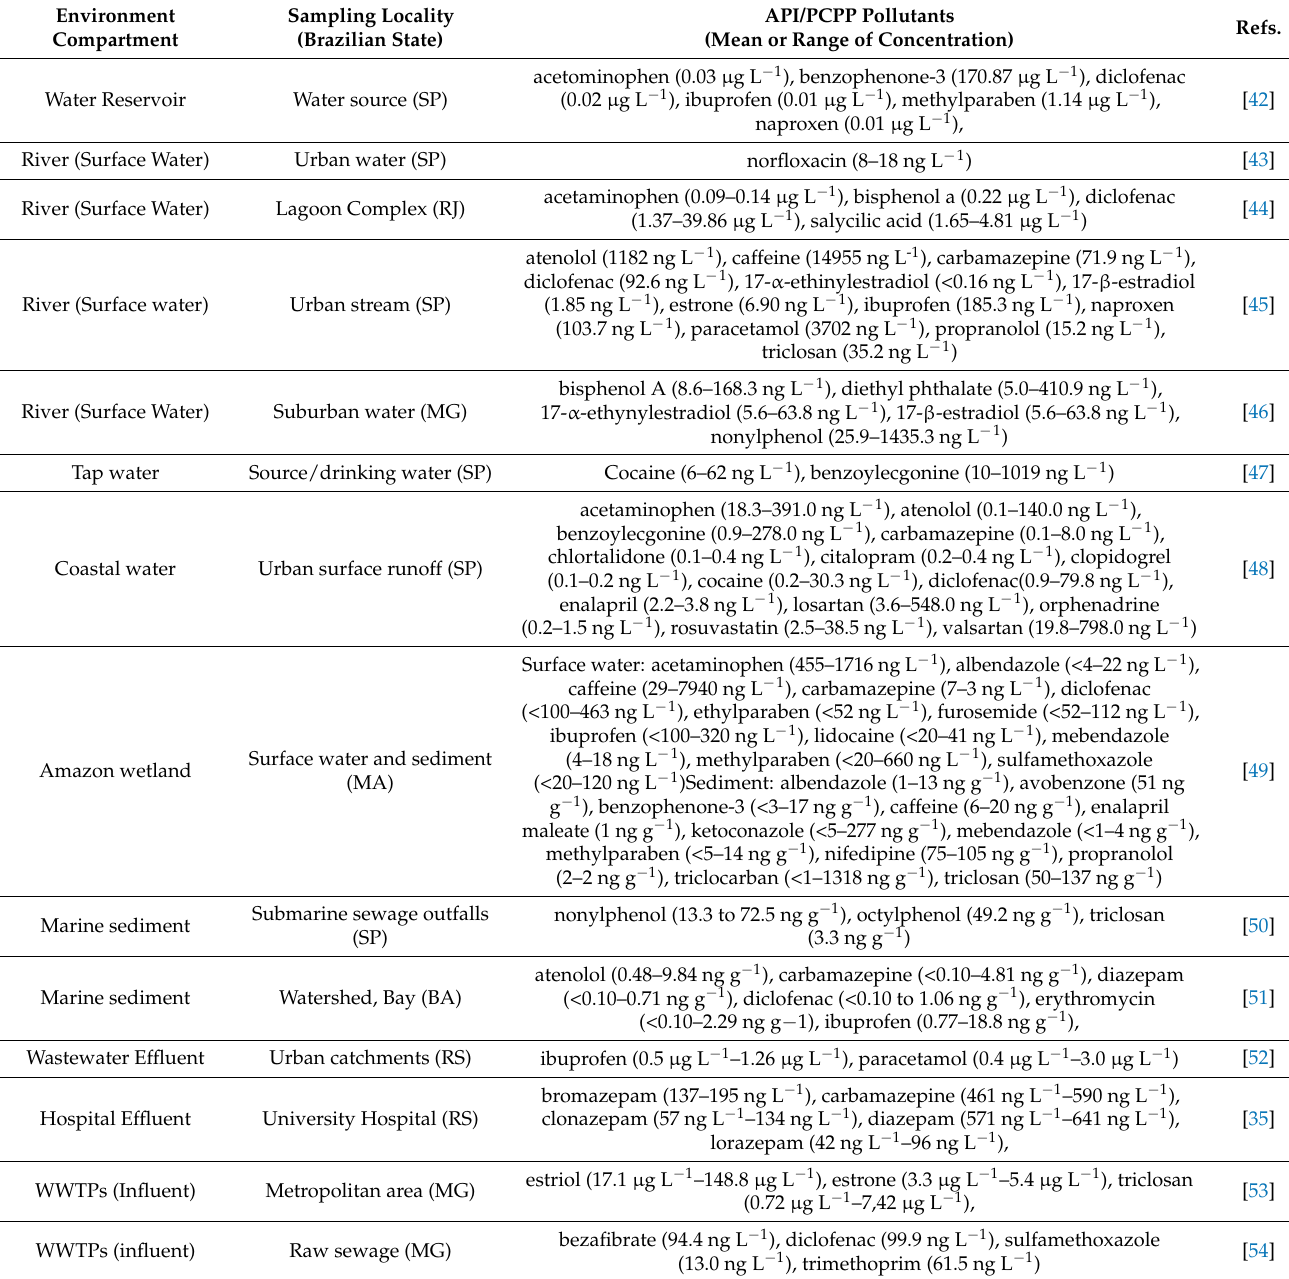
In Table 2, some APIs and PCPPs found in several kinds of water bodies and sediments in Brazil are summarized. Table 2. Some reported APIs and PCPPs found in water bodies and sediment in Brazilian